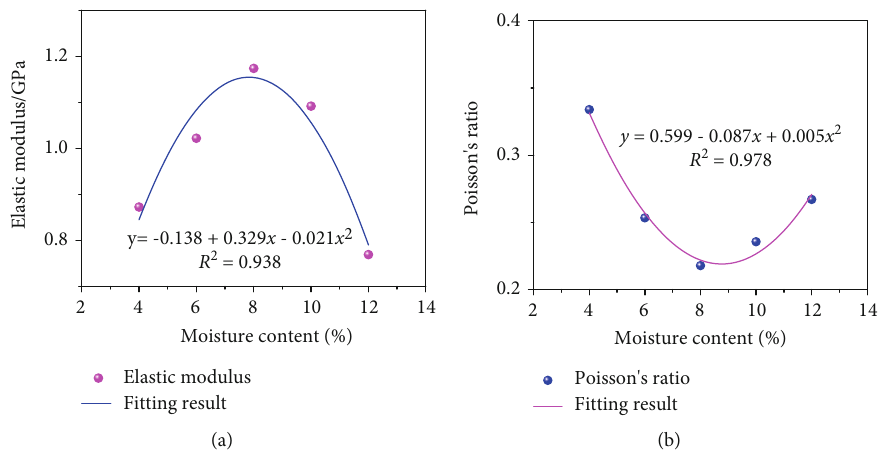
Figure 6: Relationship between moisture content and Elastic modulus and Poisson ’ s ratio. (a) Change of Elastic modulus with moisture content. (b) Change of Poisson ’ s ratio with moisture content.